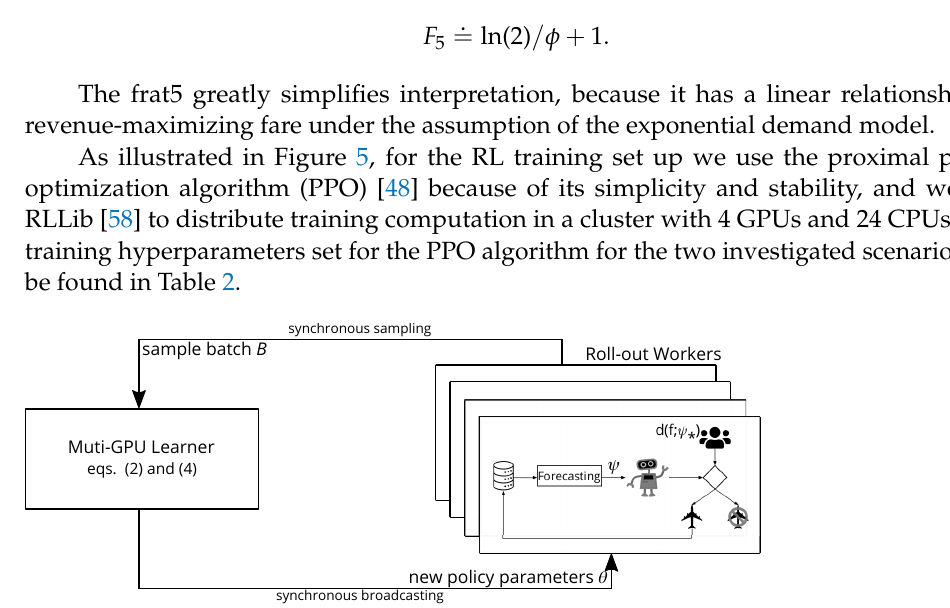
Figure 5. The proximal policy optimization algorithm training architecture for earning while learning. A copy of actor network is deployed to each roll-out worker responsible for generating training experience according to the true demand behavior specified by ψ ∗ . The agent cannot observe the true demand behavior parameters directly, and its decisions rely on exclusively the estimated demand behavior parameters ψ instead. The training experience generated by all roll-out workers are aggregated into a batch and then sent to the learner which is responsible for updating the neural networks weights. Table 2. Training hyperparameters. “ep.” abbreviates episode. The RLLib implementation of PPO dedicates one CPU to the master thread, which is not used for generating